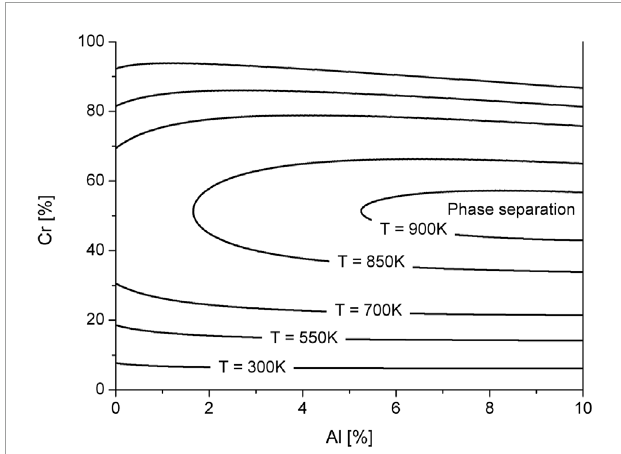
FIGURE 1 Phase diagram of the alloy Fe − Cr − Al at different values of the annealing